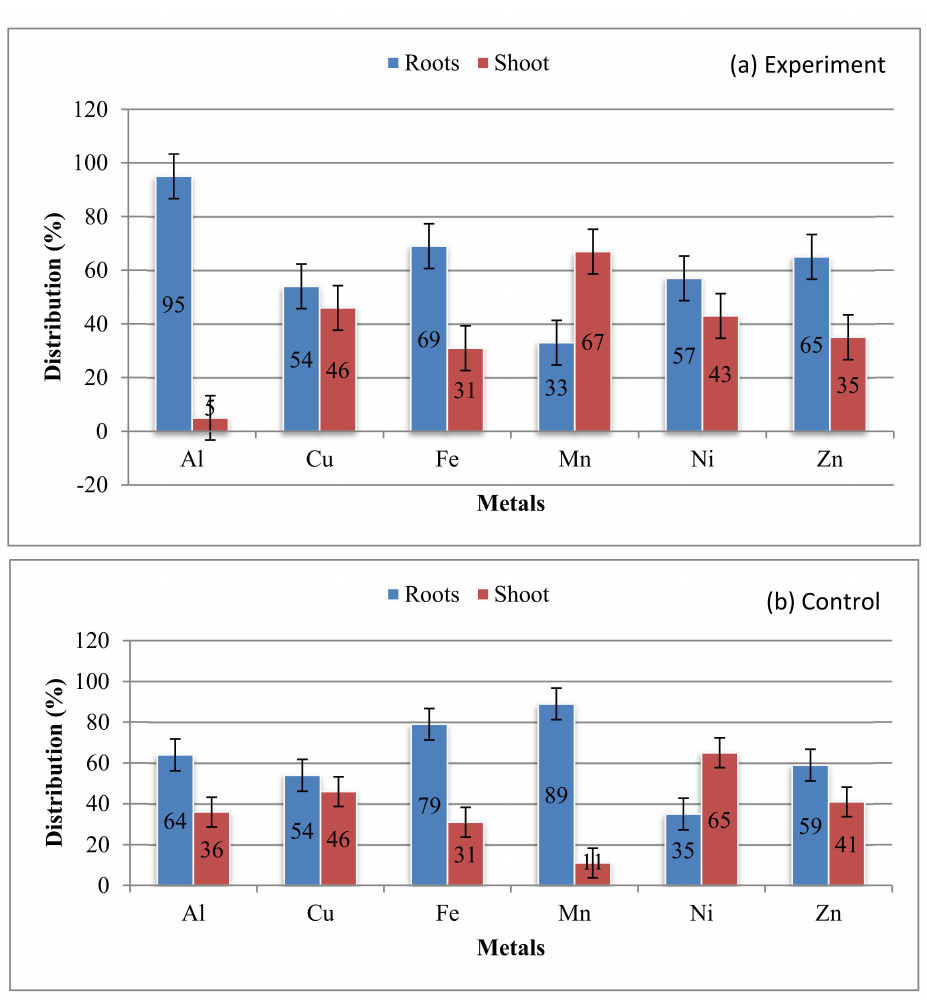
Figure 6. ( a ) Percentages of the metal distribution partitioned into roots and shoots (treatment wetland). ( b ) Percentages of the metal distribution partitioned into roots and shoots (control